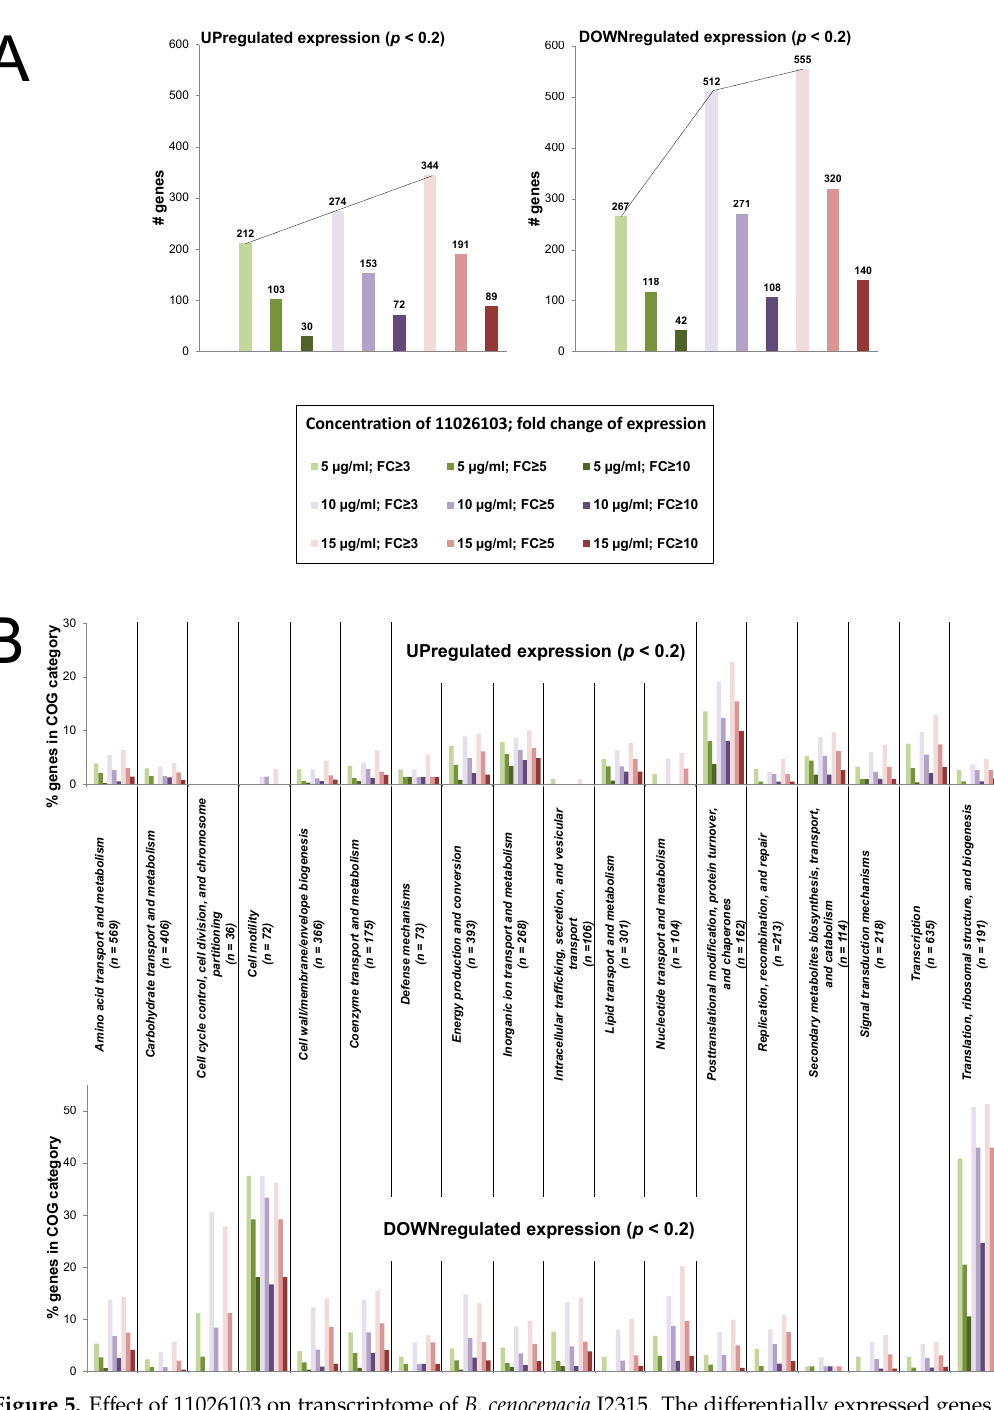
Figure 5. E ff ect of 11026103 on transcriptome of B. cenocepacia J2315. The di ff erentially expressed genes are color-coded according to the concentration of 11026103 used (sub-inhibitory: 5 µ g mL − 1 ; inhibitory: 10 µ g mL − 1 and 15 µ g mL − 1 ). The extent of di ff erential expression (fold-change (FC) of expression with respect to untreated control experiment) is denoted by the intensity of corresponding colors. Genes whose di ff erential expression did not reach statistical significance ( p > 0.2) were discarded from the calculations. ( A ) Total numbers of di ff erentially expressed genes. ( B ) Representation of COG categories among di ff erentially expressed genes. Total numbers of B. cenocepacia J2315 genes in each COG category are